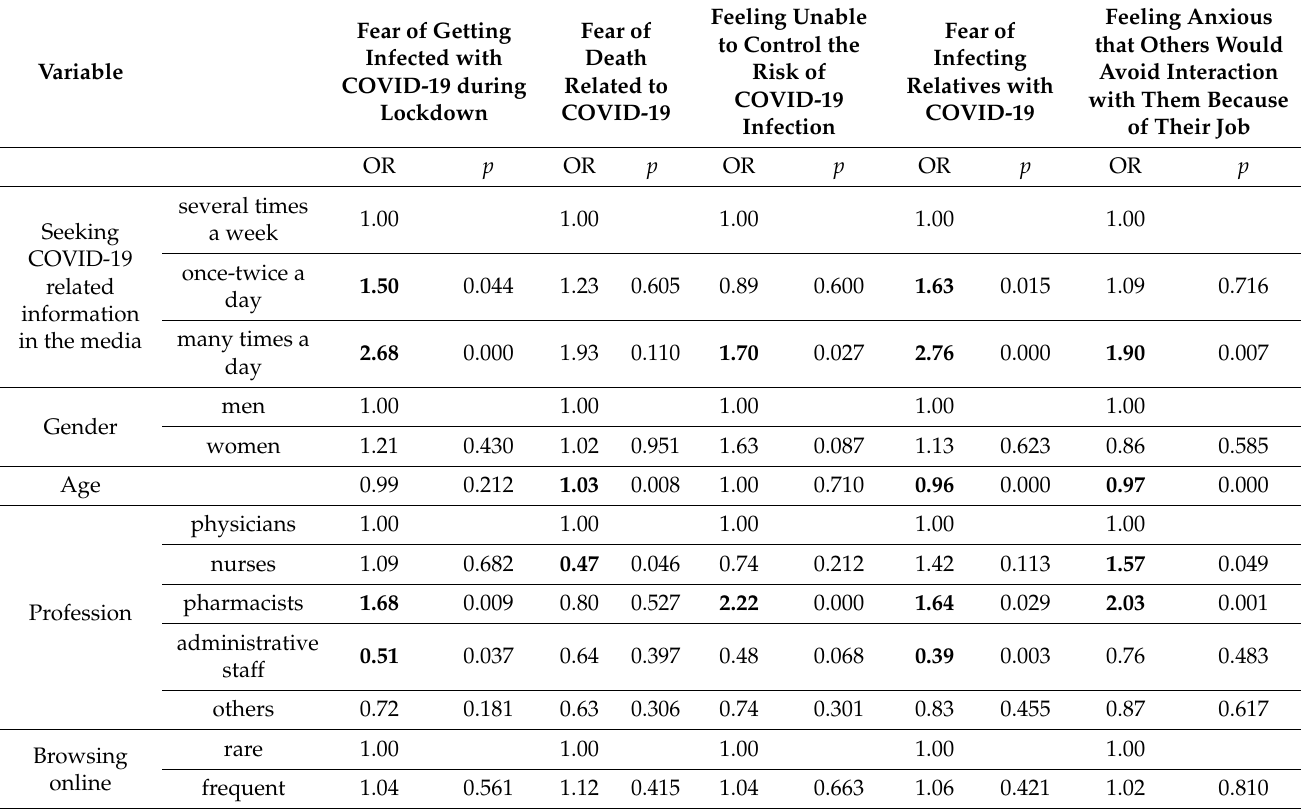
Table 3. Predicting Factors for COVID-19-Related Fears